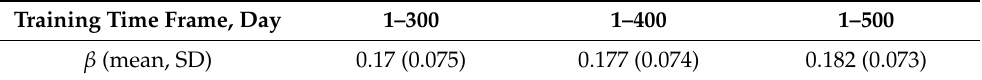
Table 1. Calculated values for transmission rate at the different training time frames. Training Time Frame,